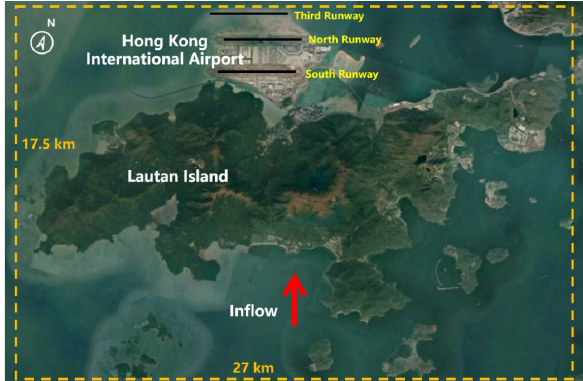
Figure 2. Hong Kong International airport and surrounding